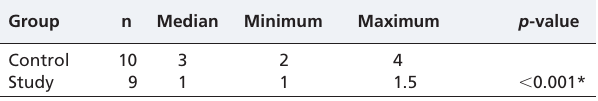
Table 5 - Analysis of vessel extent among the groups.